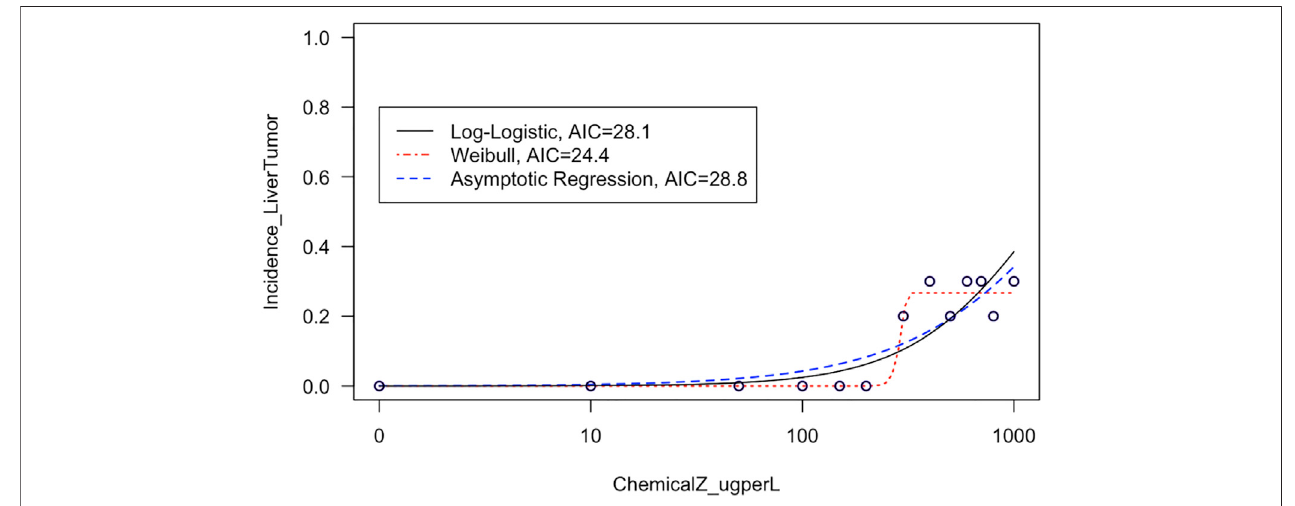
FIGURE3| Examplemodelcurvesthatare fi ttolivertumorincidencedatainthistrainingmodule.Thistrainingmoduleguidestraineesthroughtheplottingofdose- response data and the fi tting of different types of models to describe dose-response trends in these data. The fi t of each resulting curve is evaluated through visual inspection and evaluation of AIC values, and then the training module focuses on the model with the lowest AIC to derive benchmark dose estimates.